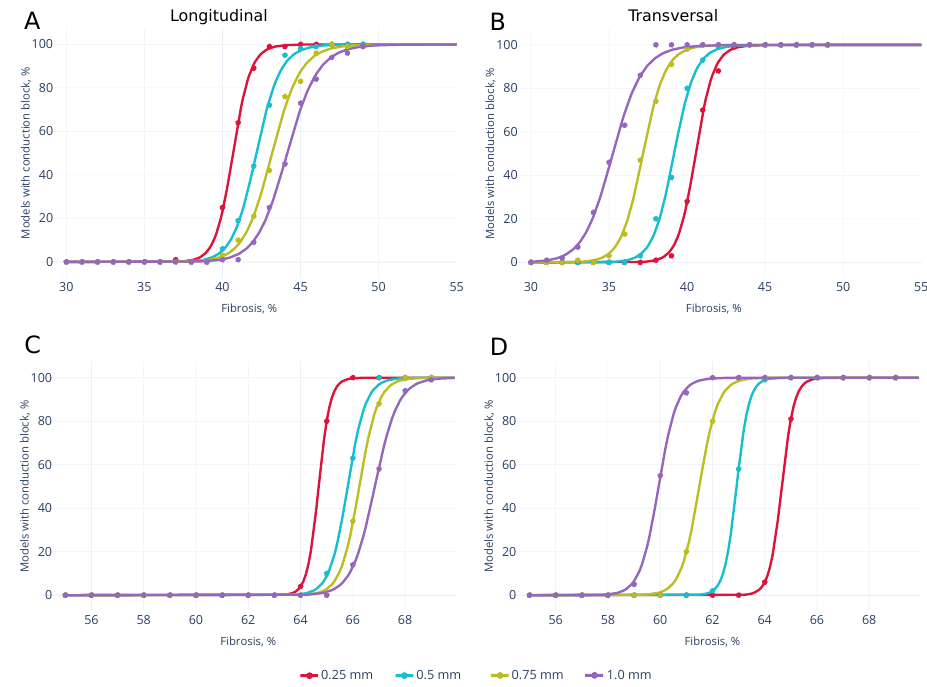
Figure 6. Fraction of models with failed wave propagation depending on the fibrosis percentage in the mono- (upper panels) and multilayer (lower panels) tissue for longitudinal (panels A , C ) and transversal (panels B , D ) wavefront direction. Dots show percentage of models, solid lines show approximation by logistic curves.